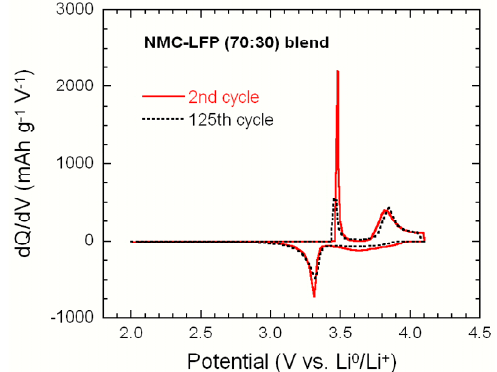
Figure 11. Incremental capacity d Q /d V of the NMC–LFP (70:30) blended electrode vs. potential as a function of the cycle number.